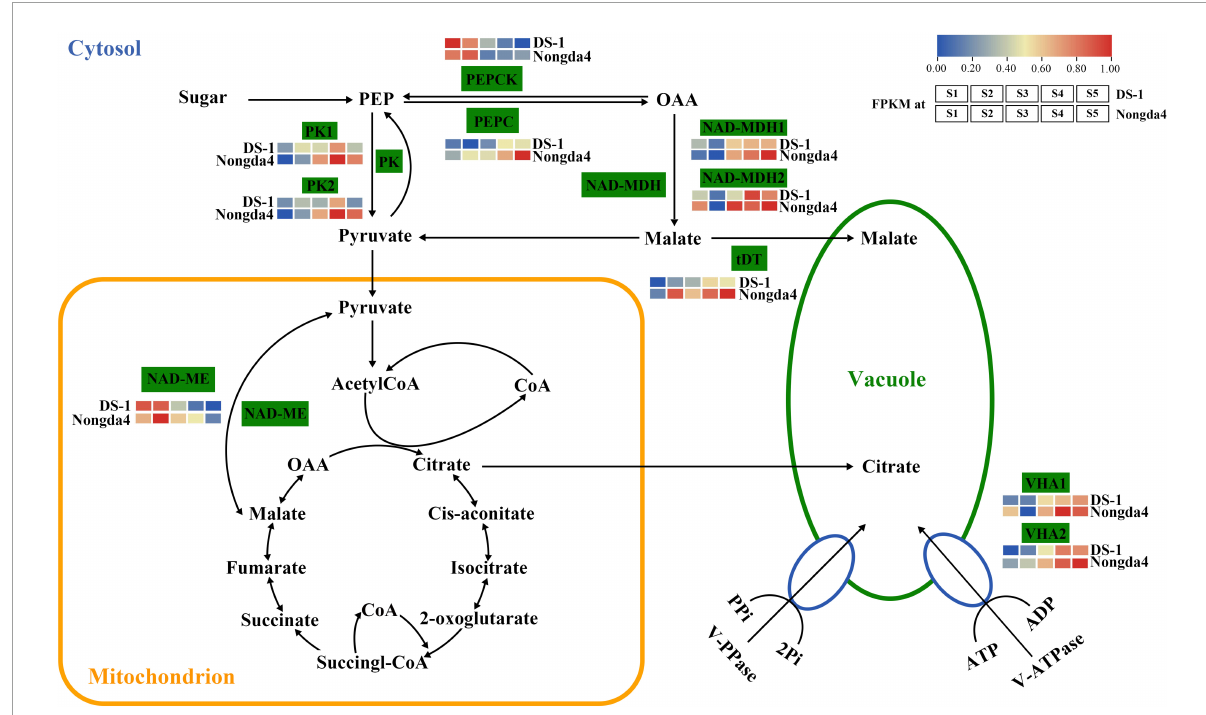
FIGURE10 The organic acid biosynthetic pathway Enzyme names are shown along with their expression patterns at various stages. Grids represent the expression patterns of genes shown as FPKM values: S1, S2, S3, S4, and S5, left to right. NAD-ME, NAD-malic enzyme; NAD-MDH, NAD-malate dehydrogenase; PEPCK, phosphoenolpyruvate carboxykinase; VHA, V-type ATPase; PEPC, phosphoenolpyruvate carboxylase; PK, pyruvate kinase; tDT, tonoplast dicarboxylate